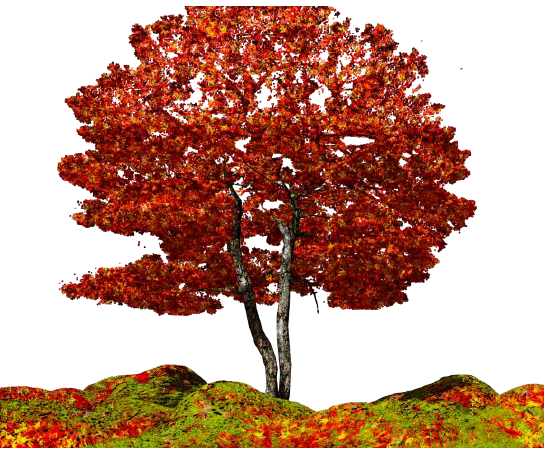
Figure 13. Application to deciduous tree model